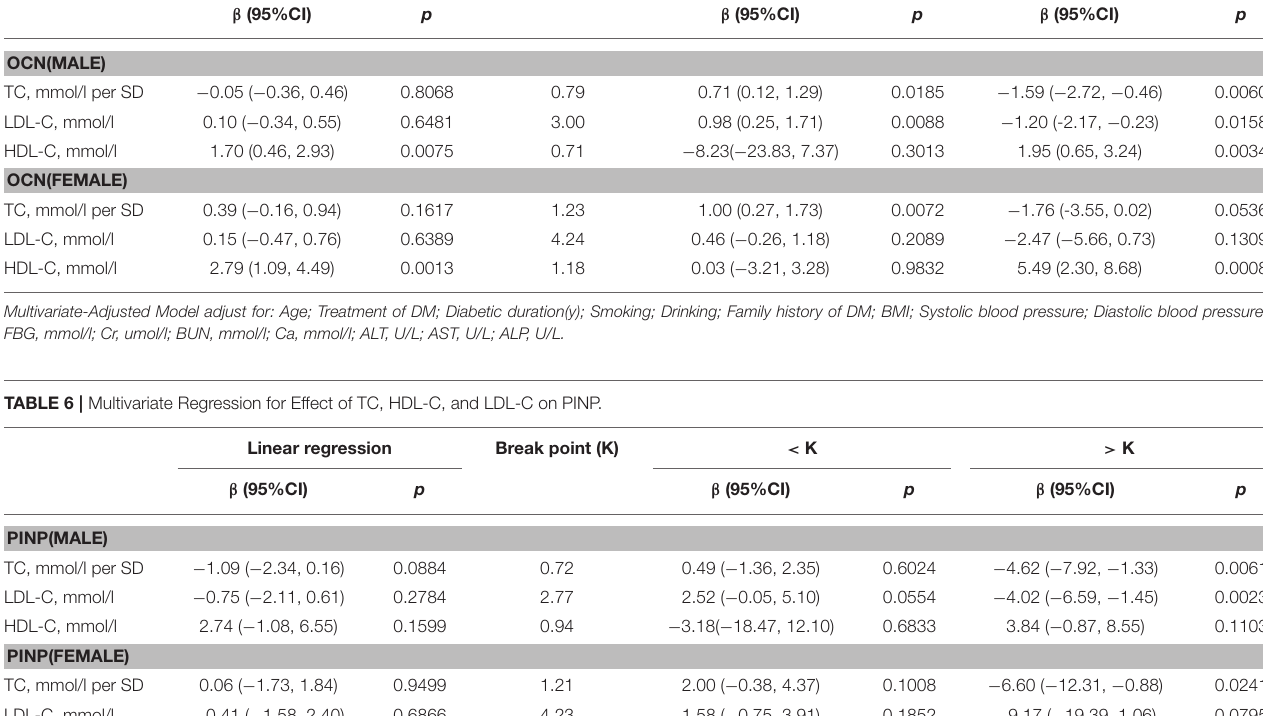
TABLE 5 | Multivariate Regression for Effect of TC, HDL-C, and LDL-C on OCN. Linear regression Break point (K) < K > K β (95%CI) p β (95%CI) p